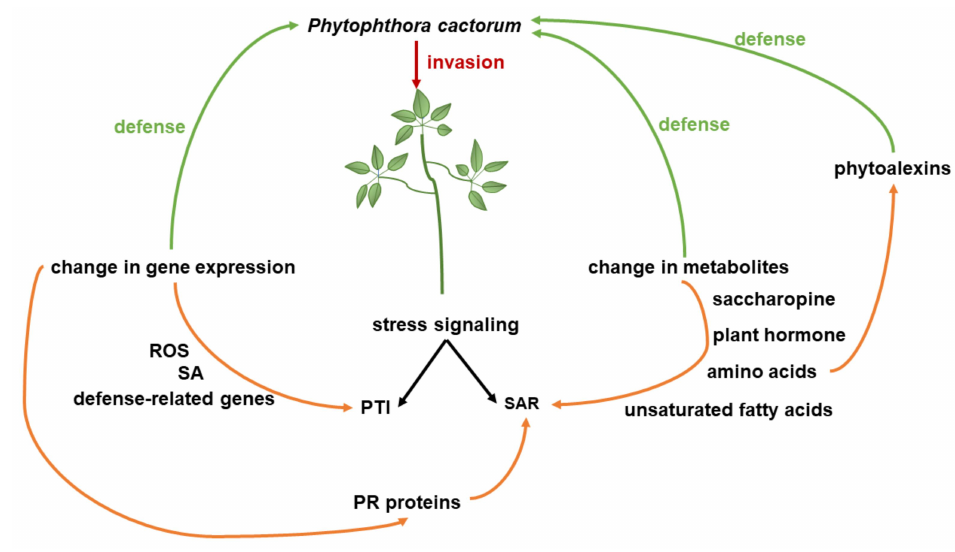
Figure 12. Underlying molecular stress response of ginseng plants to the P. cactorum infection.